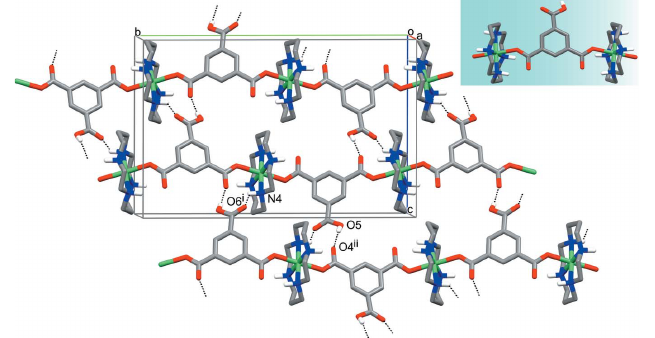
Figure 3 The hydrogen-bonded (dashed lines) sheet in II . C-bound H atoms and water molecule of crystallization have been omitted; the intramolecular hydrogen bonds are not shown. The mode of coordination of carboxylate ligand is shown as an inset. Symmetry code: (i) x (cid:3) 1, y , z . , (cid:3) y + 1 , z + 1 . 2 2 2